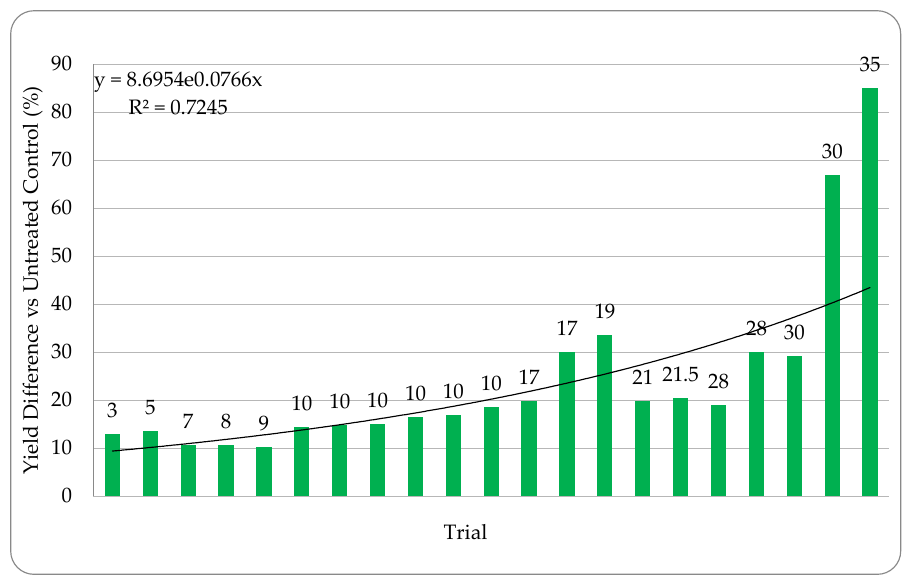
Figure 6. Corn Percent Yield Difference vs Stress. Stress increases left to right from 3 – 35 with level of stress indicated above each bar as described in the materials and methods. Higher stress levels are indicated by higher numbers. Trials were performed in CA, WA, MI, NE, MN, AZ, ND, and India using 10 commercial hybrids with standard PPP’s. Each bar is a separate trial and plots sizes varied from 10 ft × 50 ft to 50 acres. The bars indicate the percent difference in yields of ThMS3a treated versus the untreated controls. Each test had a single replication of treated and untreated so it was not possible to include standard deviations or statistical an alysis. Cooperators: CRO’s, seed companies, farmers, universities.